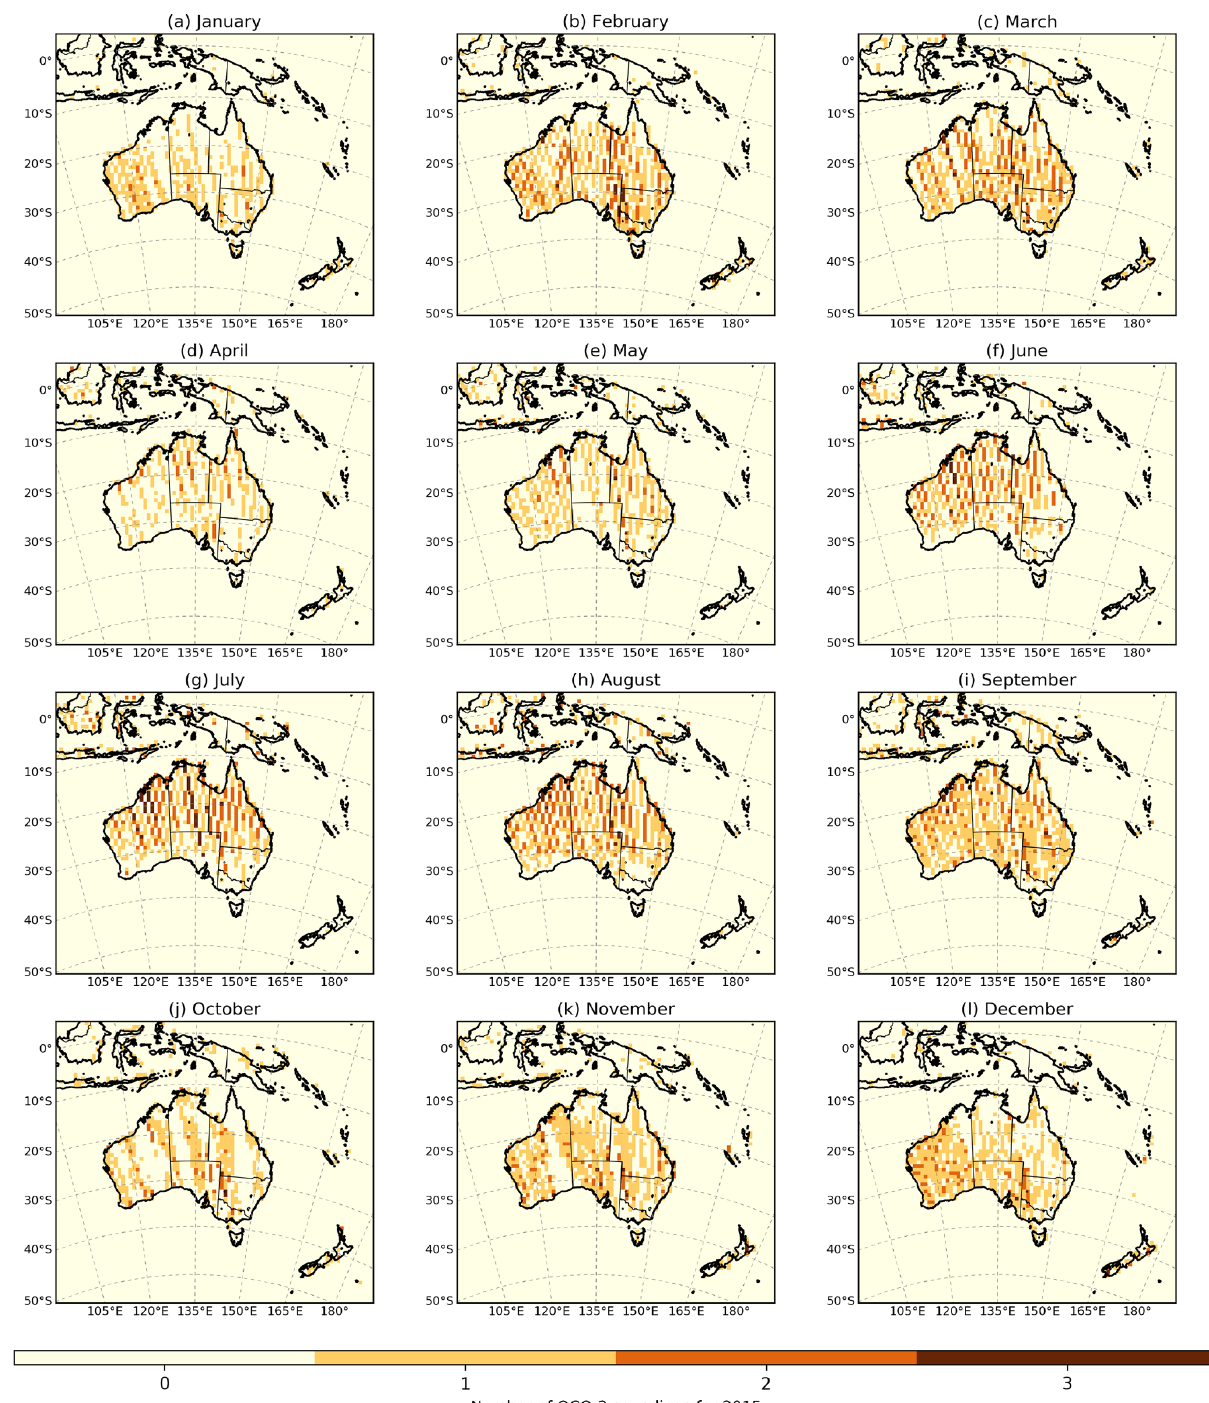
Figure E1. Spatial distribution of OCO-2 soundings (land nadir and glint data) over the CMAQ domain for 2015.